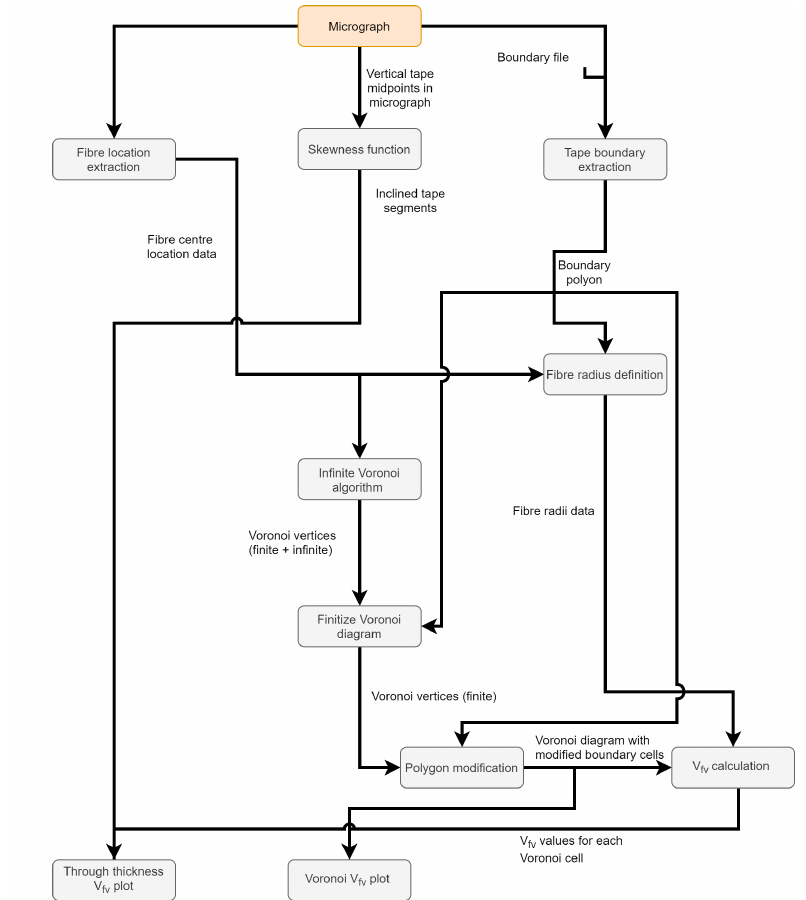
Figure A1. Microstructural characterisation algorithm flow